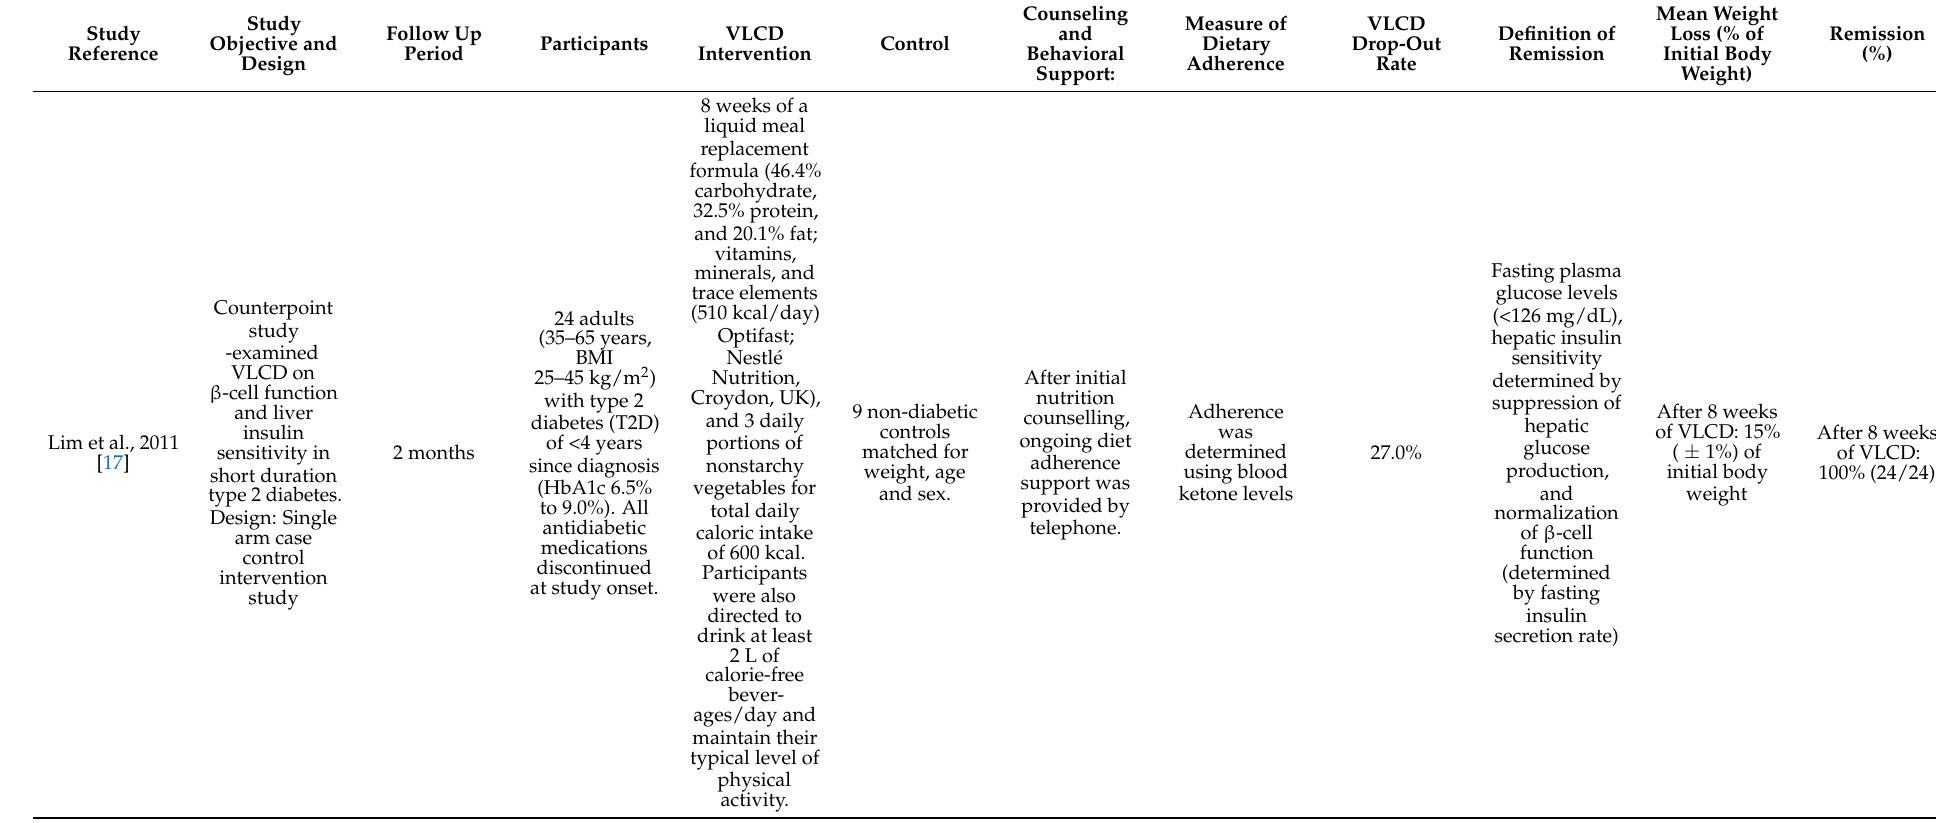
Table 1. Very low-calorie diet (VLCD) interventions for remission of type 2 diabetes